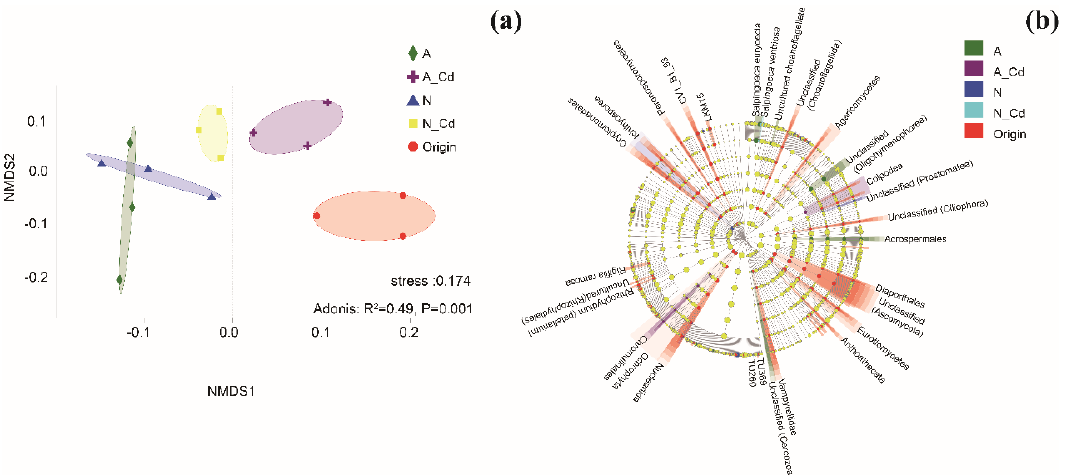
Figure 2. Multidimensional scaling (NMDS) ordination ( a ) and linear discriminant analysis effect size (LEfSe) cladogram ( b ) of fungal communities among the different treatments and origin. Treatment abbreviations are defined in Figure 1.